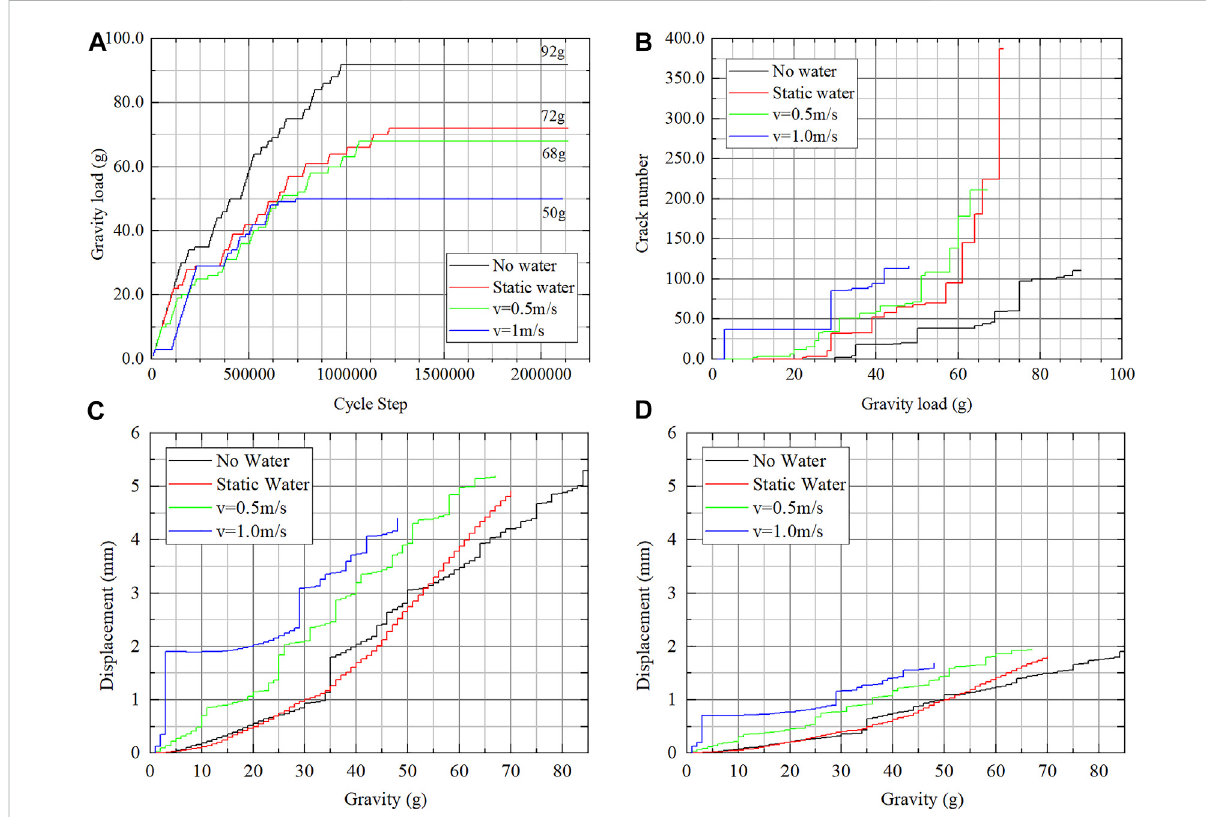
FIGURE 11 Contrast of the instability process: (A) collapse load; (B) crack number; (C) horizontal displacement of point A; and (D) horizontal displacement of point B.